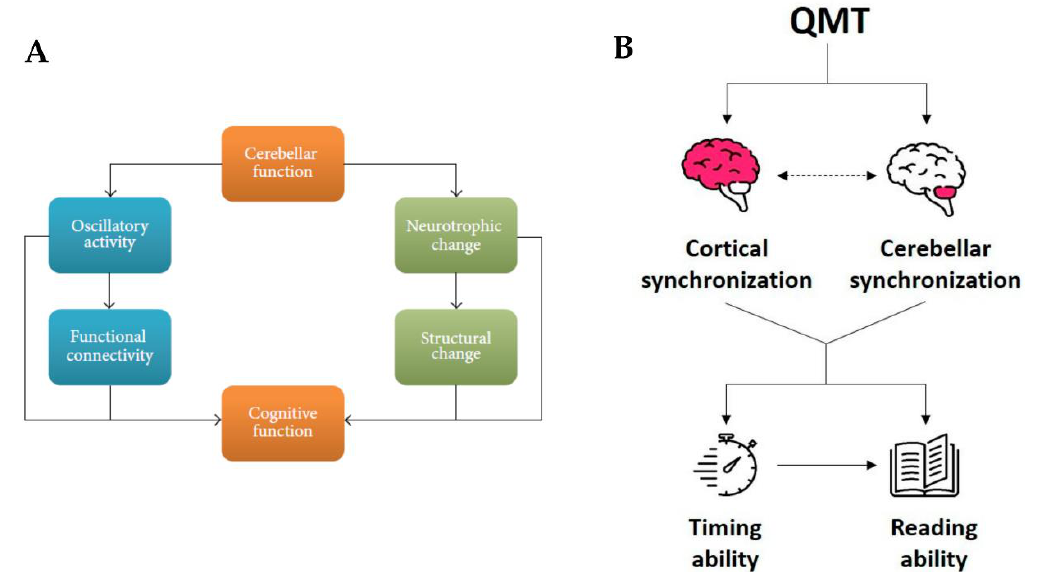
Figure 2. ( A ) Interconnected relationship between cerebellar and cognitive function. The relationship is mediated via two interrelated routes. The first is slow rhythm oscillations, manifested in functional connectivity; the second is molecular effects on structural changes in connectivity. Adapted from [15]. ( B ) Effects of the QMT on both timing and reading abilities mediated by the interconnected relationship between cortical and cerebellar synchronization. Adapted from [16].